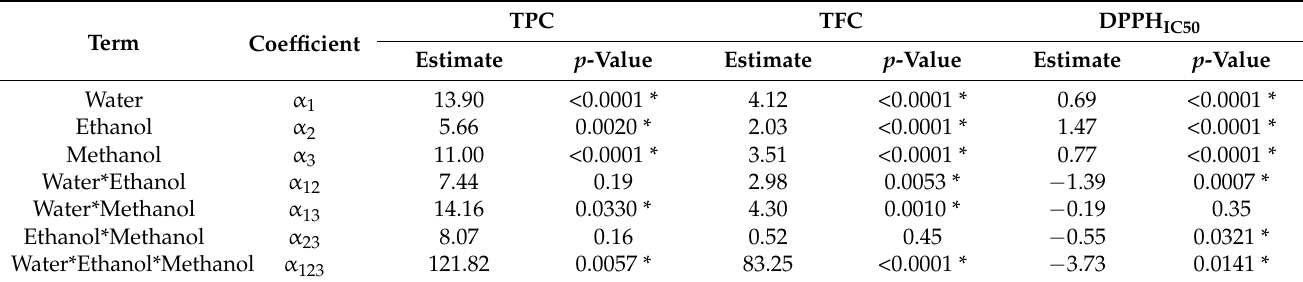
Table 4. Estimated regression coefficients of the special cubic model.